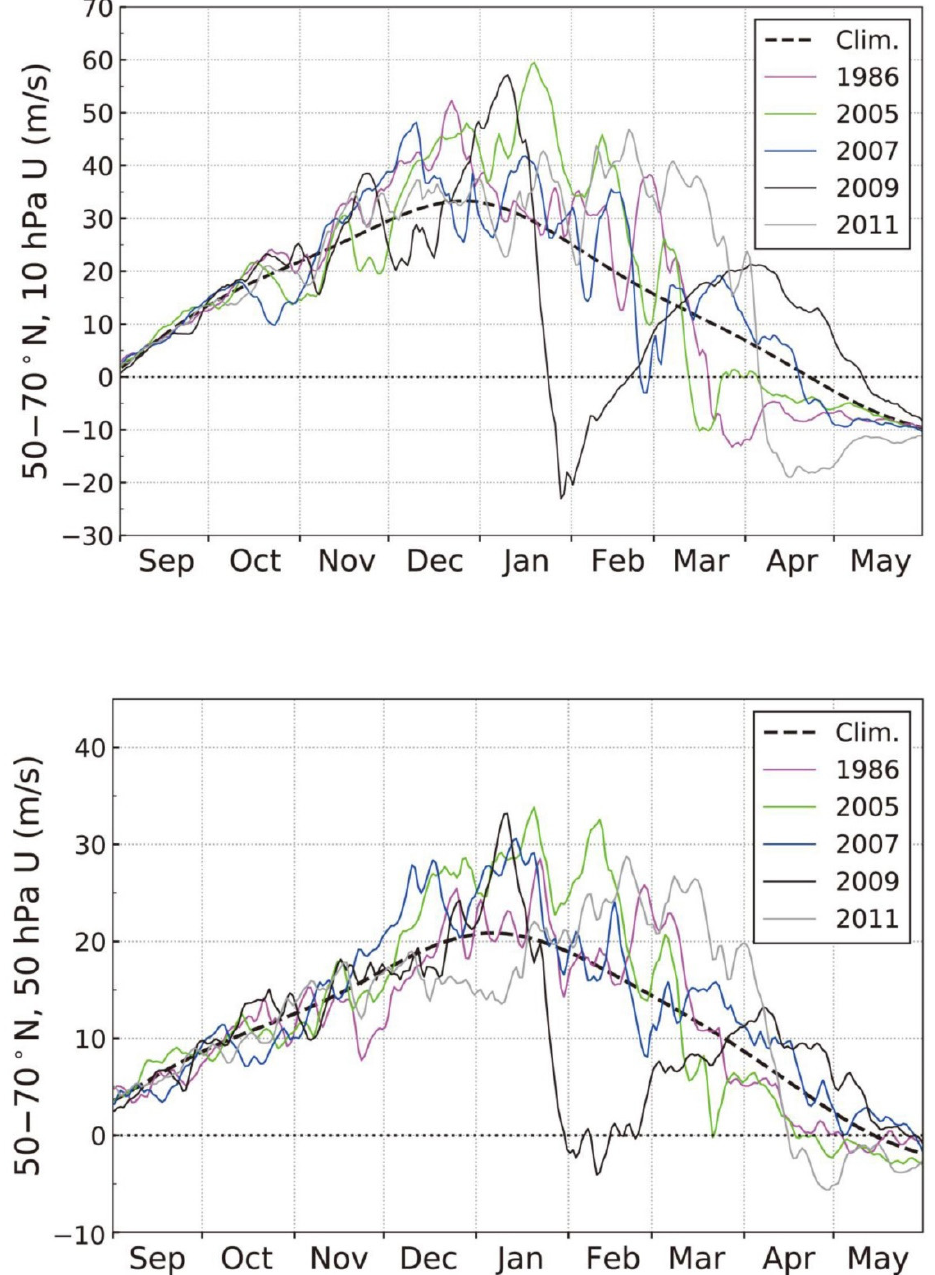
Figure 5. Daily time-series of the zonal mean zonal wind over 50 − 70 N at 10 hPa (upper panel) and 50 hPa (lower panel) from ERA-Interim reanalysis data (solid lines with units of m/s). Purple line: 1986 (September 1985 − May 1986), green line: 2005, blue line: 2007, black line: 2009, and gray line: 2011. The broken line denotes the daily climatology of the zonal wind from 1979 − 2011, smoothed using a Fourier filter with a rectangular window of 3 months.